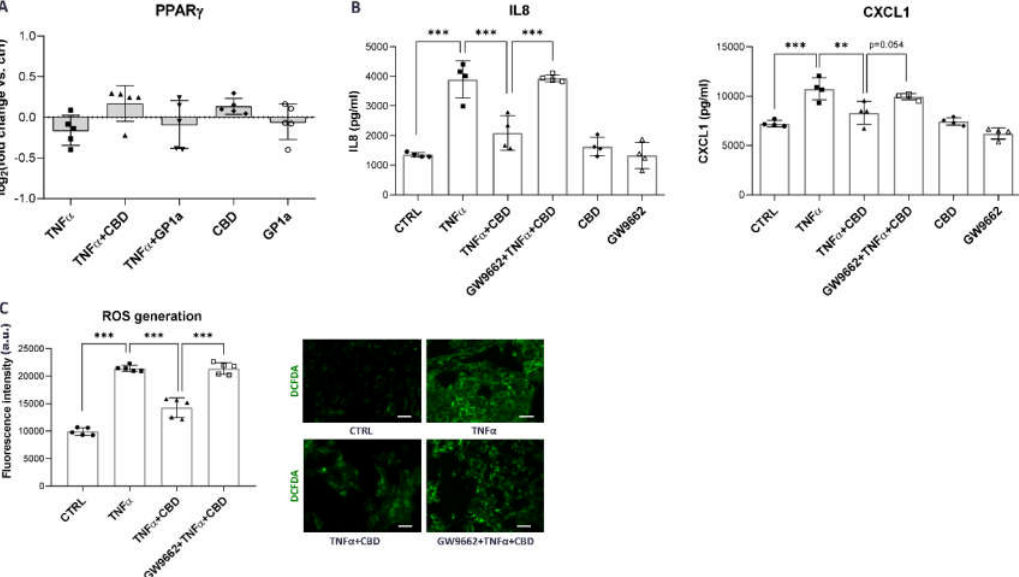
Figure 5. Diminished anti-inflammatory and anti-oxidant effects of CBD in the presence of PPARγ inhibitor. ( A ) mRNA expression of PPARγ in SV-HUC1 cells treated with TNFα (20 ng/mL) in the presence/absence of CBD (5 µM) or GP1a (5 µM) for 24 h determined by qPCR. Shown is mean ± SD log2 fold change vs. untreated control (set to 0) determined in five independent experiments. ( B ) Protein levels of IL8, and CXCL1 released into the supernatants of SV-HUC1 cells treated with TNFα (20 ng/mL) in the presence/absence of CBD (5 µm), with/without a 2 h pre-incubation with a selective PPARγ antagonist GW9662, for 24 h determined by ELISA. Shown is mean ± SD of concentrations determined in four independent experiments. ( C ) Cellular ROS generation in SV-HUC1 cells treated with TNFα (20 ng/mL) in the presence/absence of CBD (5 µM) with/without a 2 h pre-incubation with a selective PPARγ antagonist GW9662 for 24 h and stained with DCFDA (green). Shown is mean ± SD fluorescence intensity determined in four independent experiments and representative images of three independent experiments performed. Images were taken at 10× magnification. Scale bars: 50 µm. a.u., arbitrary units; ** p < 0.01; *** p < 0.001.